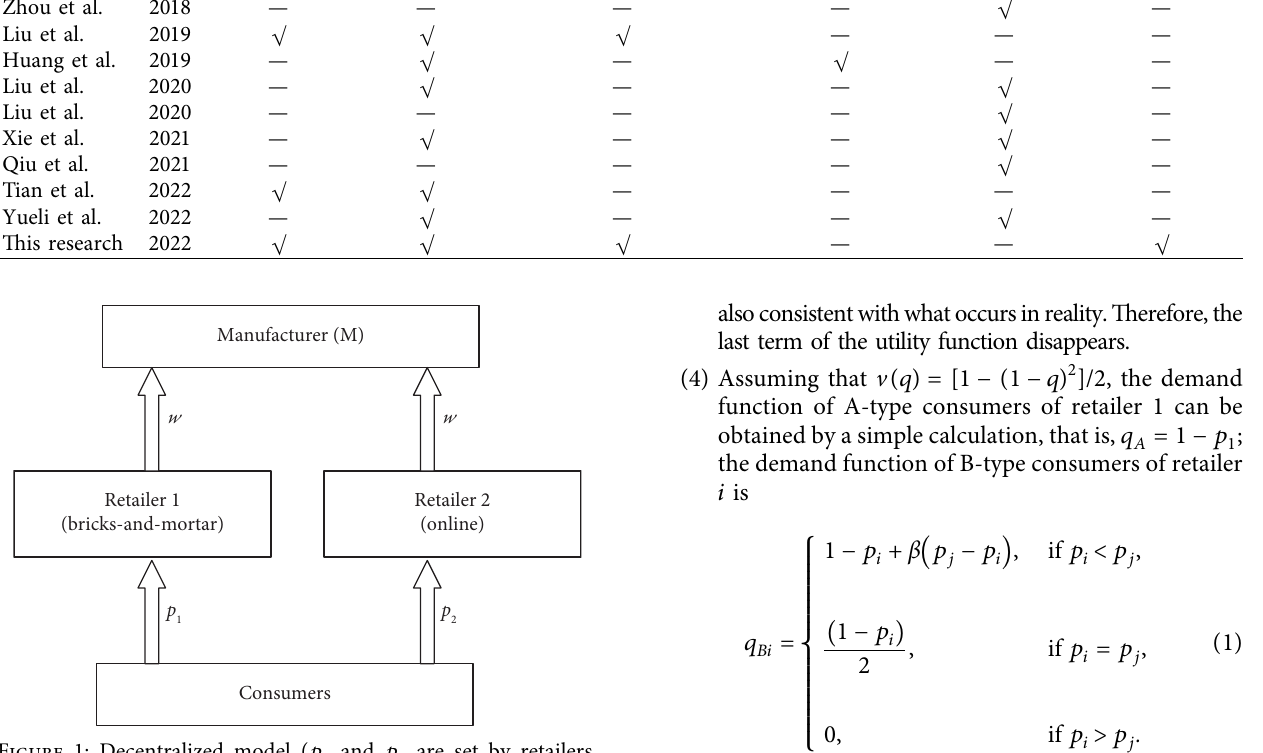
Figure 1: Decentralized model ( p respectively).